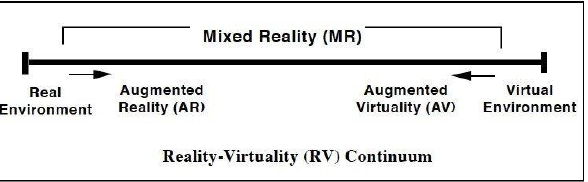
Figure 1: Virtuality Continuum (Milgram & Kishino,